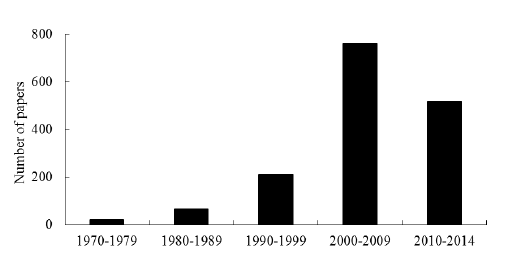
Figure 2. Total production of papers concerning freshwater benthic invertebrates per decade (excepting the 2010-2014 period) in